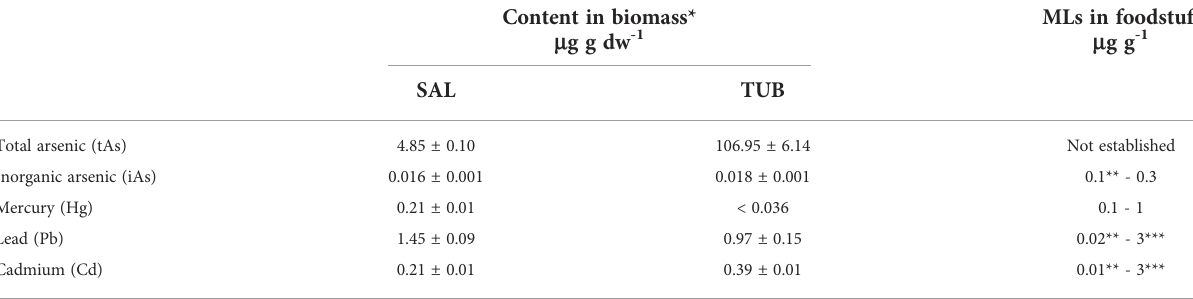
TABLE 3 Heavy metal content ( m g g dw -1 ) in Ulva fenestrata cultivated in the two herring production process waters salt brine (SAL) and tub water (TUB) after 28 days (mean ± SEM, n = 2), as well as the maximum allowed levels in foodstuff (MLs) set by the European Union ’ s Commission Regulation (EC) No. 1881/2006 (version